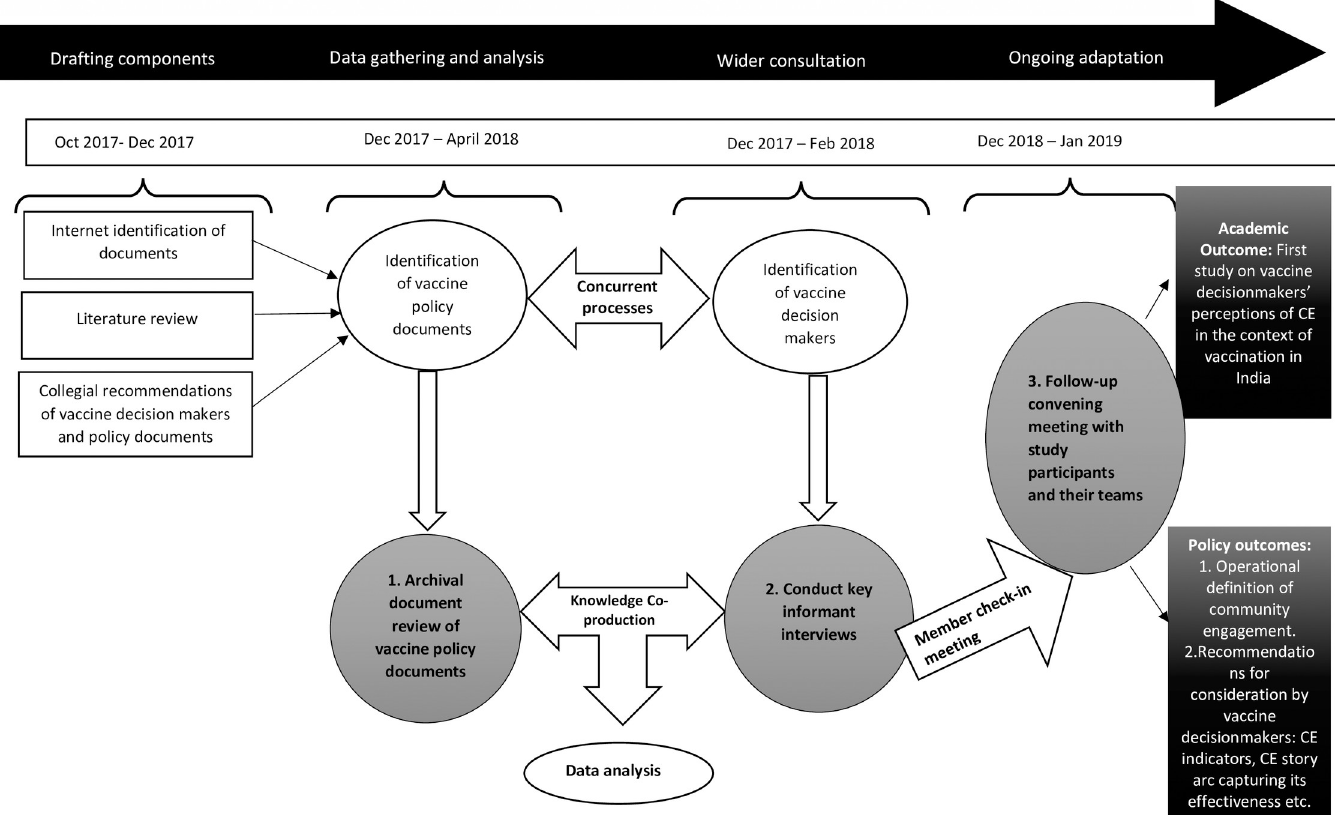
Fig 1. Visual depiction of sequential, and multi-staged qualitative study design to examine community engagement (CE) for vaccination in India, 2018.